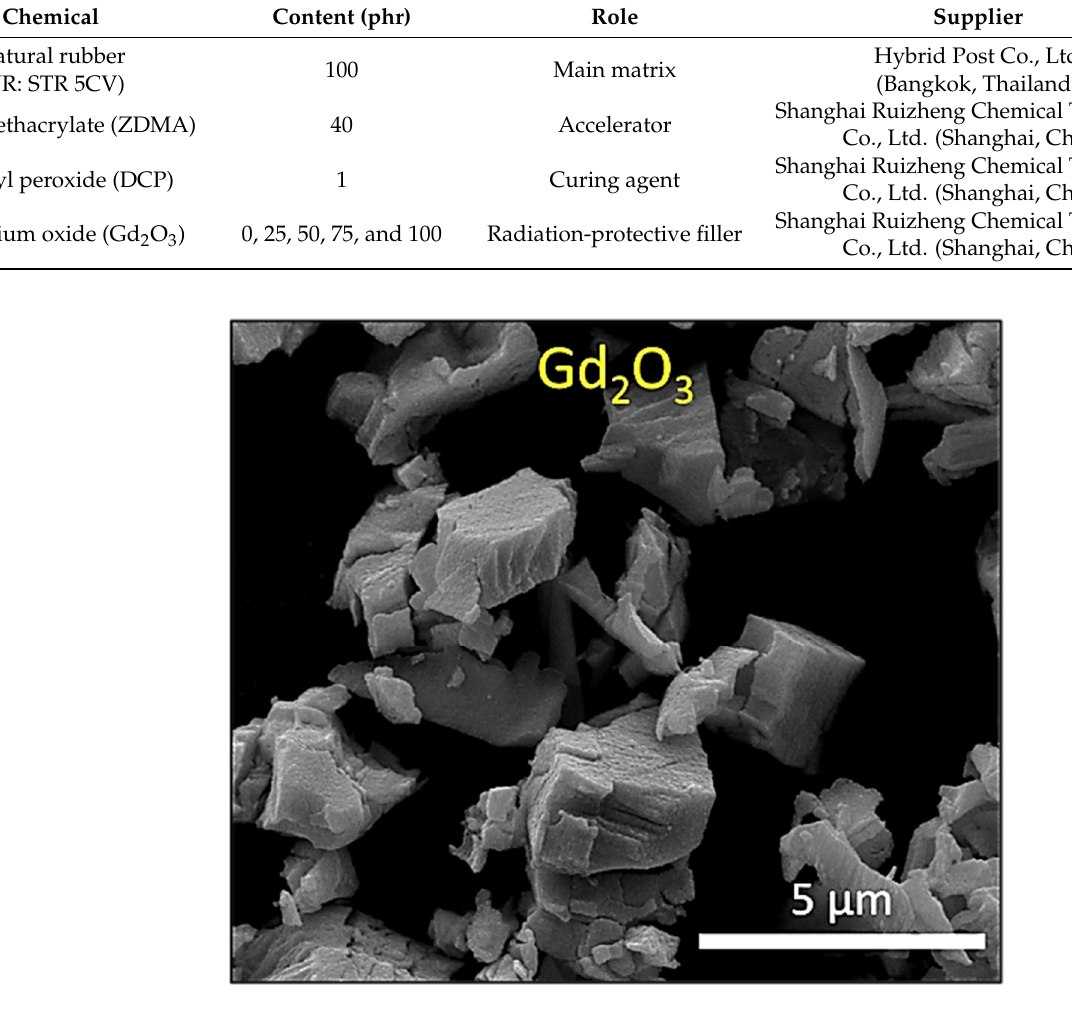
Figure 1. SEM image of Gd 2 O 3 particles used in this work. Table 1. Material formulations of Gd 2 O 3 /NR composites and their chemical names, contents, roles, and suppliers.